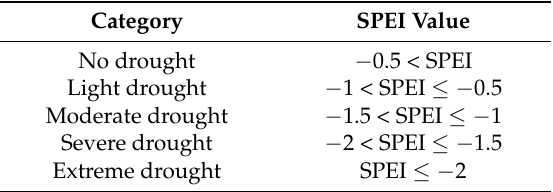
Table 1. Drought classification defined for the Standardized Precipitation Evapotranspiration Index